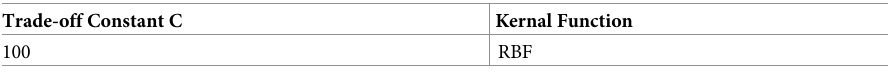
Table 9. Parameters for SVR model by Wrapper